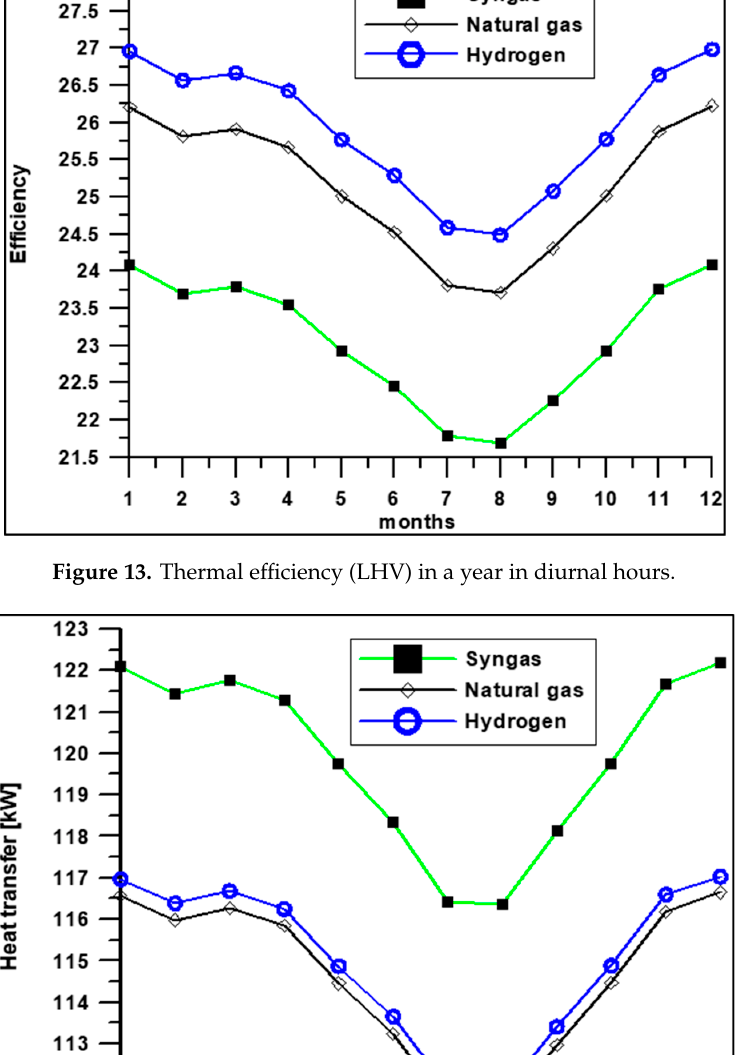
Figure 12. Net Power in a year in diurnal hours.